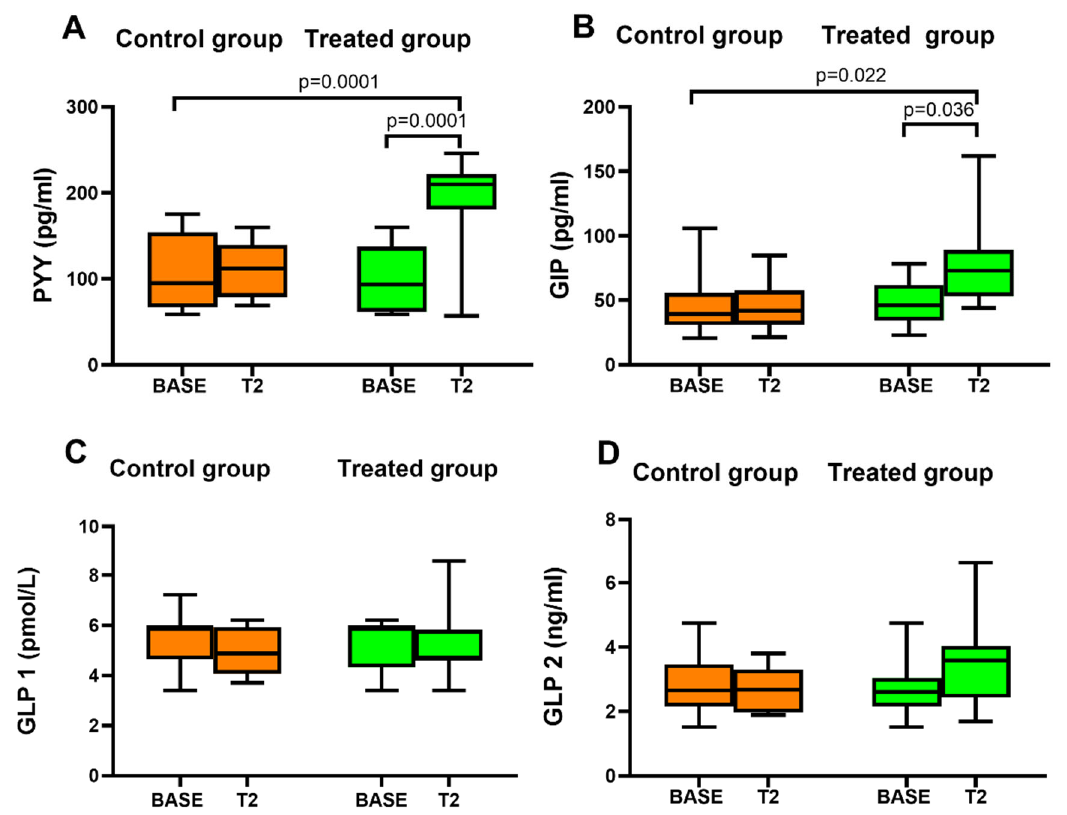
Figure 3. Gastrointestinal peptide concentrations measured at baseline (BASE) and after 12 days of lettuce consumption in the control group and in the treated group ( A ) Box and whisker plot of Peptide YY (PYY). ( B ) Box and whisker plot of Gastric Inhibitory Polypeptide (GIP). ( C ) Box and whisker plot of Glucagon-Like Peptide 1 (GLP-1). ( D ) Box and whisker plot of Glucagon-Like Peptide 2 (GLP-2).